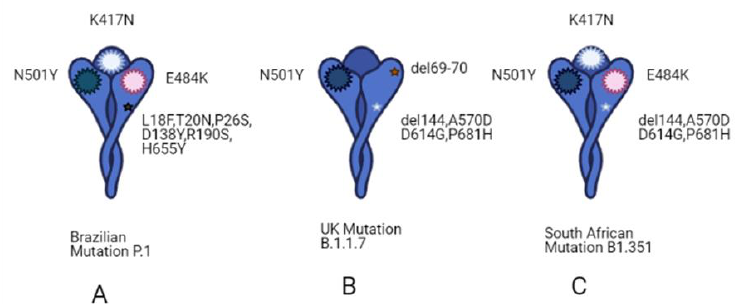
Figure 2. Schematic representation of spike variants. ( A ) Brazilian mutation called P.1, that shares three mutations in the RBD domain of spike protein with South African variants (N501Y, E484K and K417T); P.1 has 17 amino acid changes, nine of which are in its spike protein (L18F, T20N, P26S, D138Y, R190S, H655Y). ( B ) English mutation called B1.1.7 has a mutation (N501Y) in the RBD of the spike protein like P.1 and B1.351 variants. Additionally, amino acid deletions were found within the N-terminal domain (NTD) of spike protein, important for efficient entry into host cells. ( C ) South African mu- tation called B1. 351, shows a mutation in spike protein (N501Y, E484K and K417T) and several changes in NTD spike domain (A570D, D614G, P681H), including amino acid deletion (del144). [14] Created with BioRender.com .